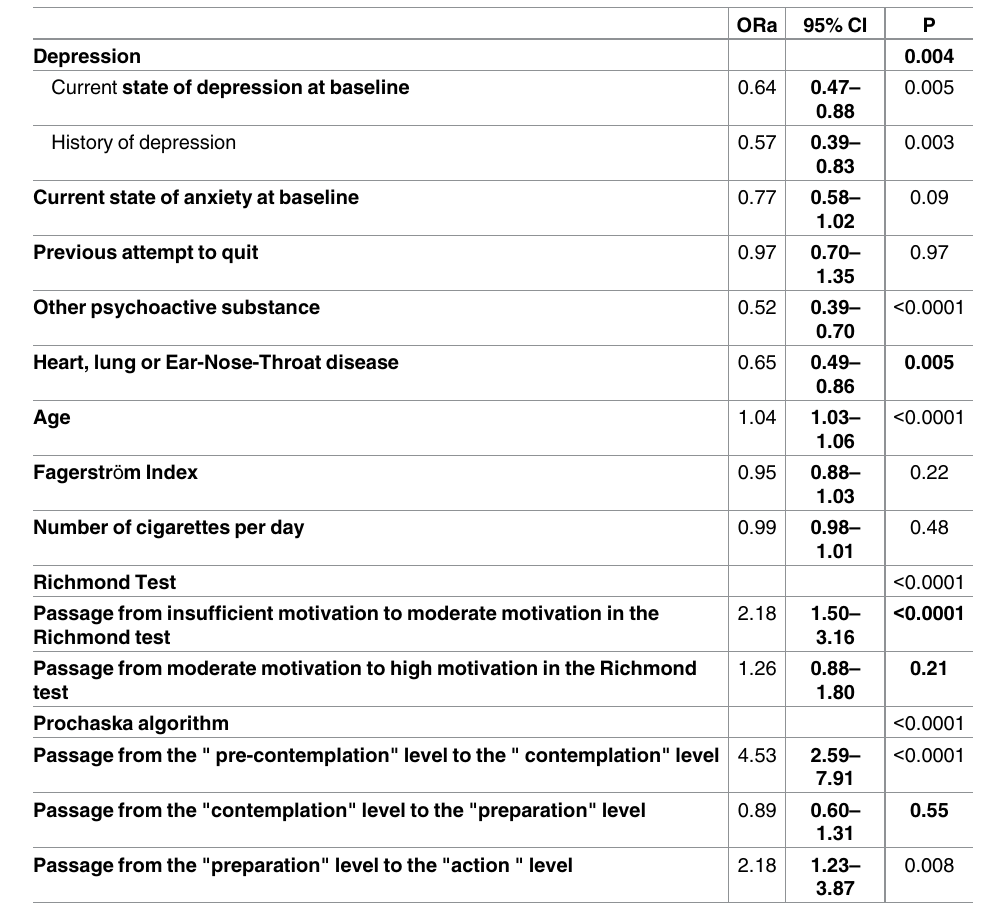
Table 3. Variables (at the initial consultation) included in the multivariate analysis (significant in uni- variateanalysis), with abstinence (binary form 1 if success, 0 if